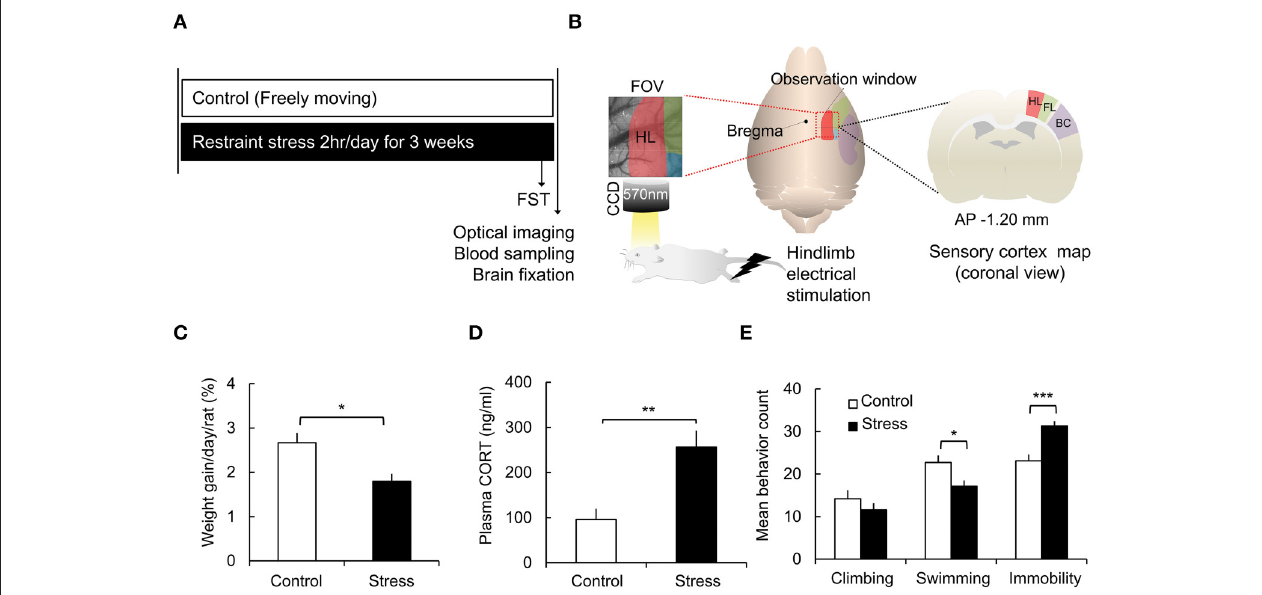
FIGURE 1 | Schematic of the experimental design and chronic stress model verification. (A) Experimental protocol. (B) Acquisition of optical intrinsic signal imaging and field of view of the rat sensory cortex [red: hindlimb area (HL), green: forelimb area (FL), blue: shoulder area, purple: barrel cortex (BC)]. (C) Comparisons of the weight gain in the control group and the stress group [Control ( n ) = 10 and Stress ( n ) = 10 ]. (D) Analysis of corticosterone concentrations in the plasma [Control ( n ) = 10 and Stress ( n ) = 10 ]. (E) Behavioral analysis of the forced swimming test [FST, Control ( n ) = 10 and Stress ( n ) = 10]. The Mann–Whitney test and independent t -test were performed to analyze the significant differences ( * p < 0.05 ; ** p < 0.01 ; *** p < 0.001